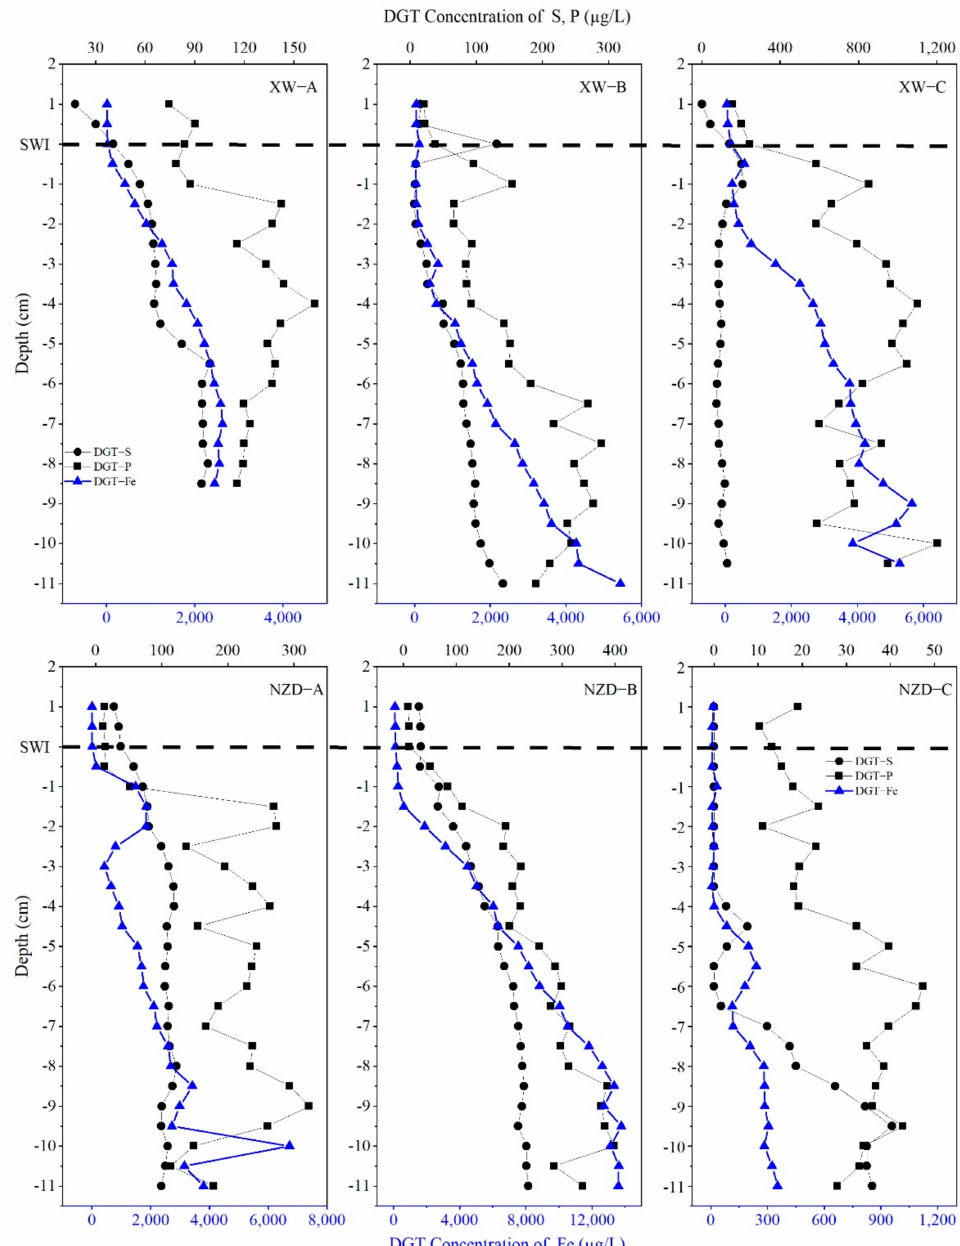
Figure 5. Vertical profiles of the P, Fe, and S concentrations measured with DGT (C DGT-P , C DGT-Fe , and C DGT-S ,